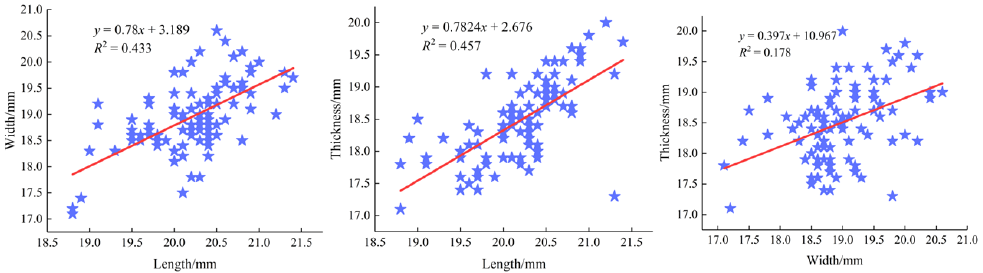
Figure 4. Scatter plot of the relationship between the triaxial dimensions of the frass aggregates. Table 1. Comparison of theoretical and actual sub-dimensions.